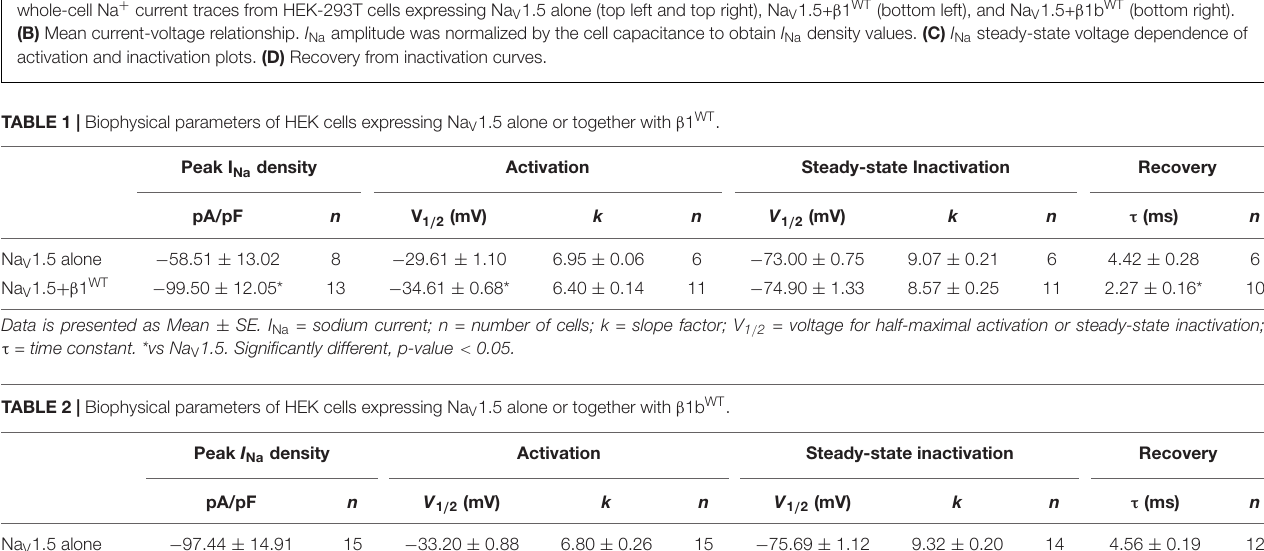
FIGURE 3 | β 1 WT and β 1b WT modulate Na V 1.5 current. Biophysical properties of sodium currents measured from HEK-293T cells expressing Na V 1.5 alone, or co-expressed with either β 1 WT or β 1b WT . Whole cell currents were elicited by depolarizing potentials as shown in the insets. Circles are used to depict data for Na V 1.5 alone, triangles for Na V 1.5+ β 1 WT , and squares for Na V 1.5+ β 1b WT . Solid lines in panels (C) and (D) represent the fitted curves. Values are expressed as mean ± SEM. The studies with the β 1 subunit are represented on the left side of the figure, and the studies with the β 1b subunit on the right side. (A) Representative whole-cell Na + current traces from HEK-293T cells expressing Na V 1.5 alone (top left and top right), Na V 1.5+ β 1 WT (bottom left), and Na V 1.5+ β 1b WT (bottom right). (B) Mean current-voltage relationship. I